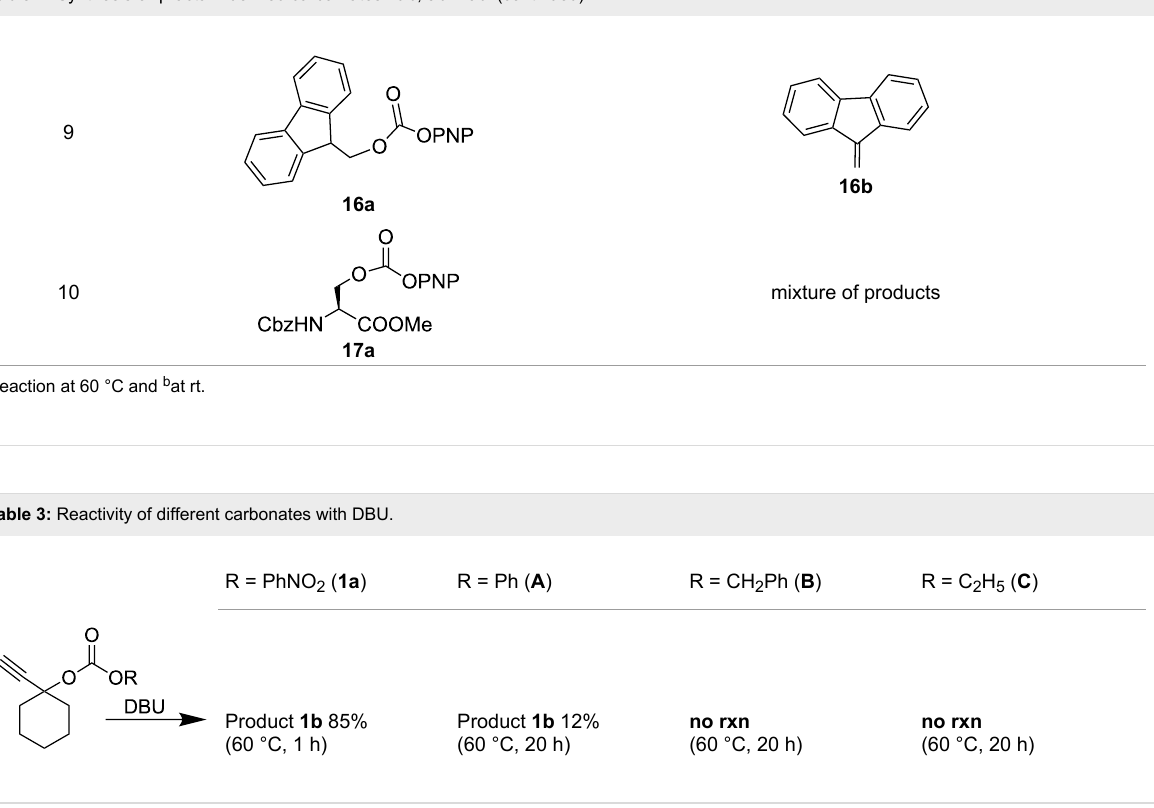
Table 2: Synthesis of γ -lactam-derived carbamates 2ab , 9b–16b . (continued)